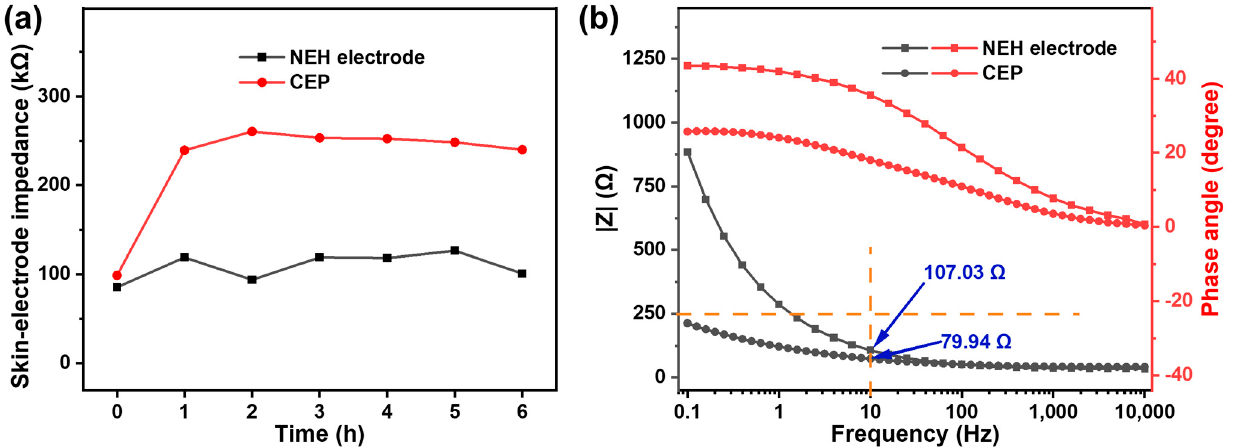
Figure 5. ( a ) Comparison of skin–electrode contact impedance at the forearm between the CEP and NEH electrode for 6 h. ( b ) Measurement for the electrode pair impedance of the NEH electrode and